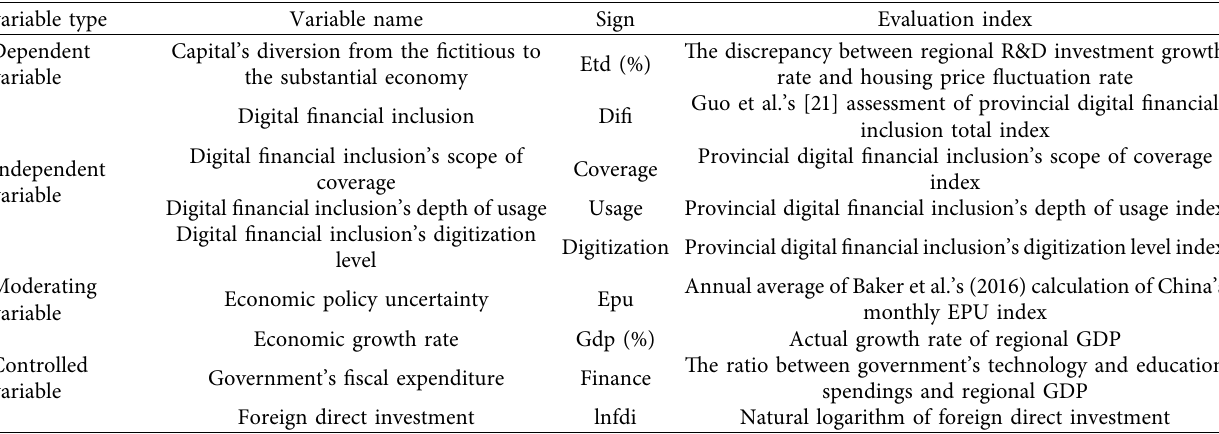
Table 1: Variable